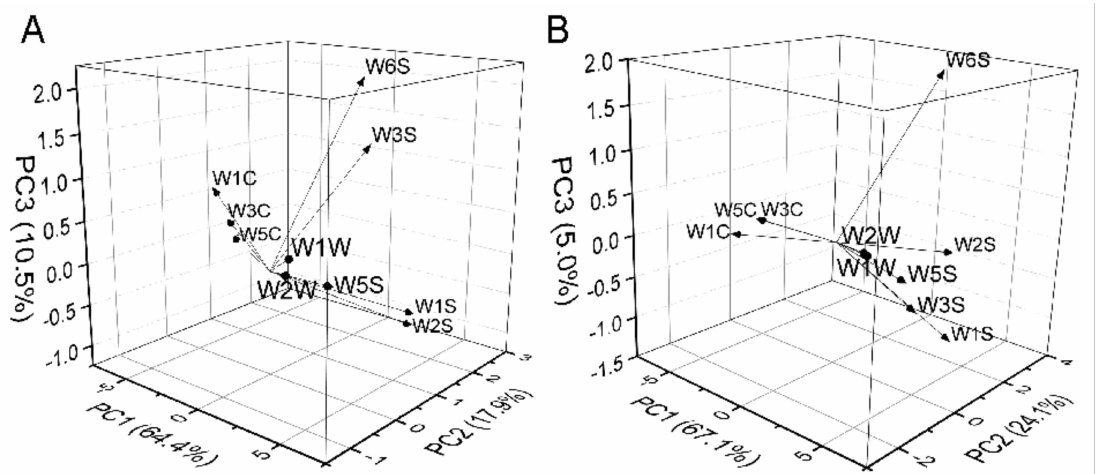
Figure 3. The load coefficient diagrams of electronic nose by principal component analysis (PCA). ( A ) The load coefficient diagrams for yolks. ( B ) The load coefficient diagrams for